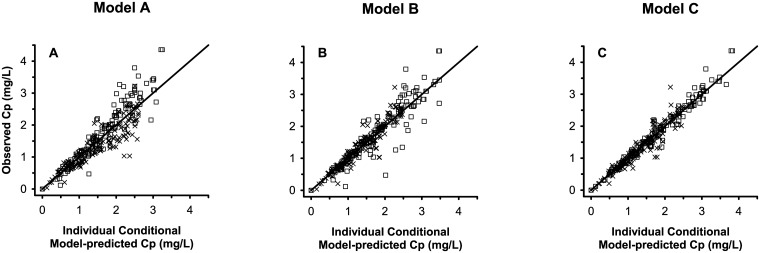
Observed vs. individual-conditional model-predicted plasma lidocaine concentrations following administration of plain or adrenalinated lidocaine in dogs.(A) Standard model (i.e. with one first-order absorption rate per system). (B) Alternative model (i.e. with two asynchronous first-order absorption rates per system). (C) Refined alternative model (i.e. with two time-constrained, asynchronous zero-order absorption rates per system). An identity line (i.e. Y = X) has been added to each plot as the expected relationship. Squares, plain lidocaine data. Cross marks, adrenalinated lidocaine data.